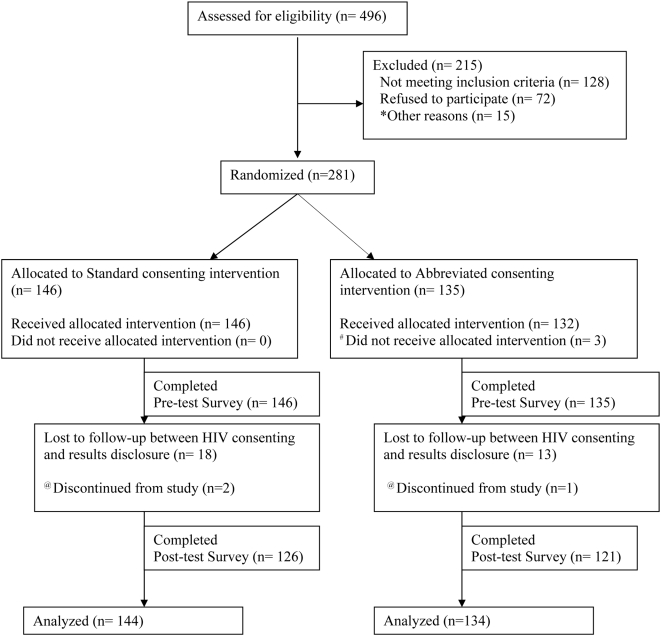
Flow Diagram Legend.* Women who were excluded for “other reasons” included women who initially consented to participate in the study but then changed their mind prior to undergoing the questionnaire. # Women who received the Standard instead of the Abbreviated consent due to nurse “error”. @ Women were discontinued from study after pre-test survey completed and they were excluded from the analysis. They were identified as being ineligible only after randomization and administration of pre-test survey.